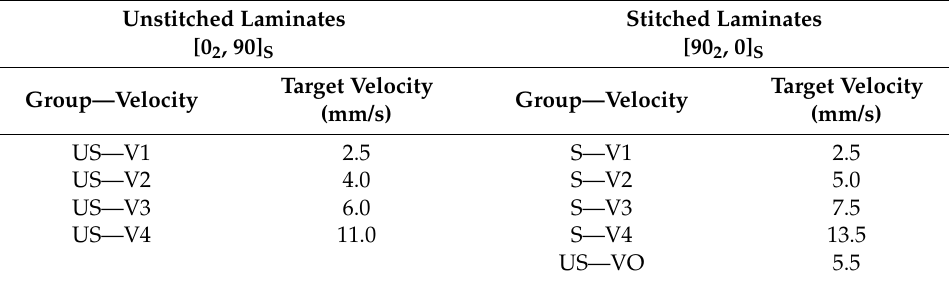
Table 1. Flow velocities used as a target for manufacturing. Unstitched Laminates Stitched Laminates [0 2 , 90] S [90 2 , 0] S Target Velocity Target Velocity Group—Velocity Group—Velocity (mm/s) (mm/s) US—V1 2.5 S—V1 2.5 US—V2 4.0 S—V2 5.0 US—V3 6.0 S—V3 7.5 US—V4 11.0 S—V4 13.5 US—VO